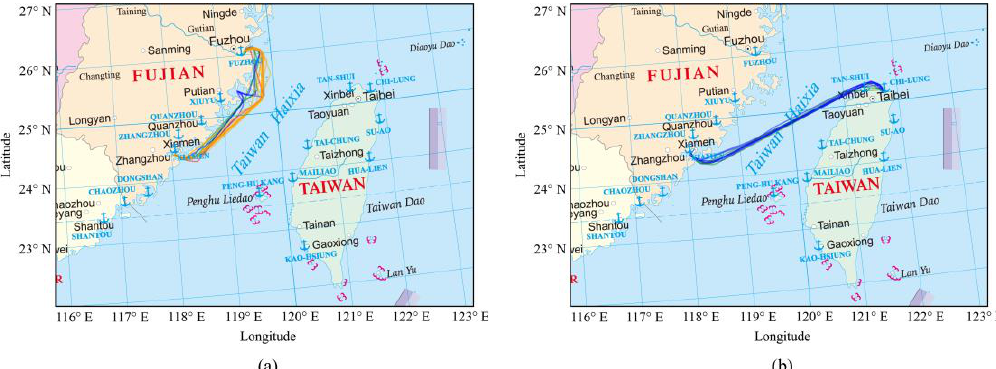
Figure 20. The modified clustering results of ship trajectories in Figure 20 based on the enhanced BIRCH algorithm. ( a ) shows the clustering results of ship trajectories from Fuzhou Port to Xiamen Port, where the ship trajectories are clustered into four groups. ( b ) shows the clustering results of ship trajectories from Xiamen Port to Keelung Port, where the ship trajectories are clustered into two groups.